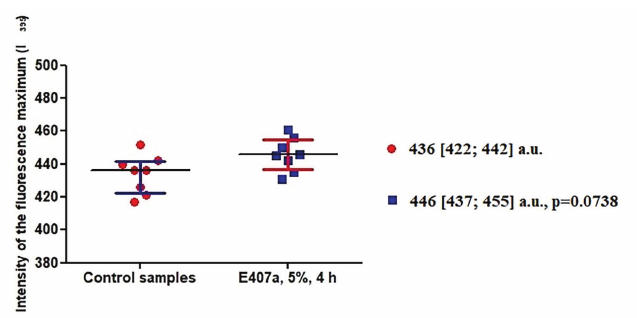
Figure 4. The intensity of the fluorescence maximum of the probe PH1 in cell membranes of intact leukocytes and white blood cells incubated with E407a